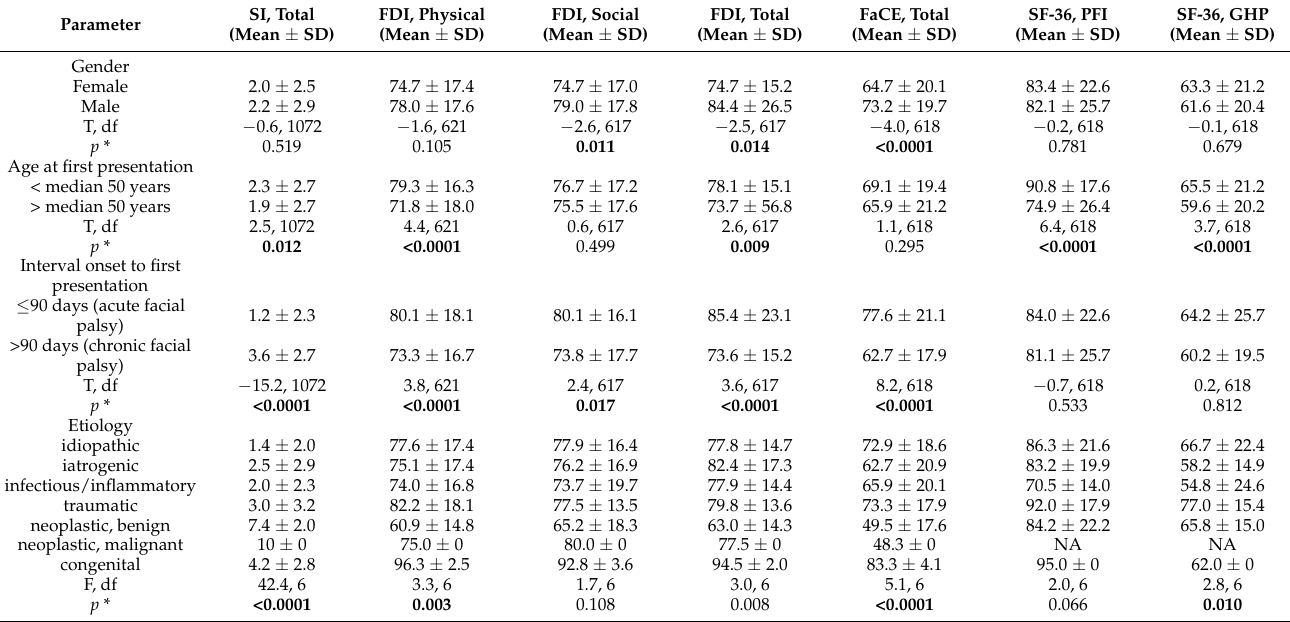
Table 5. Last facial function of patients by demographics and